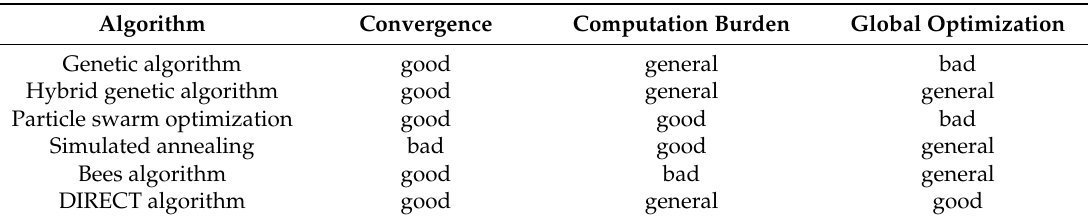
Table 1. General comparison of different algorithms.